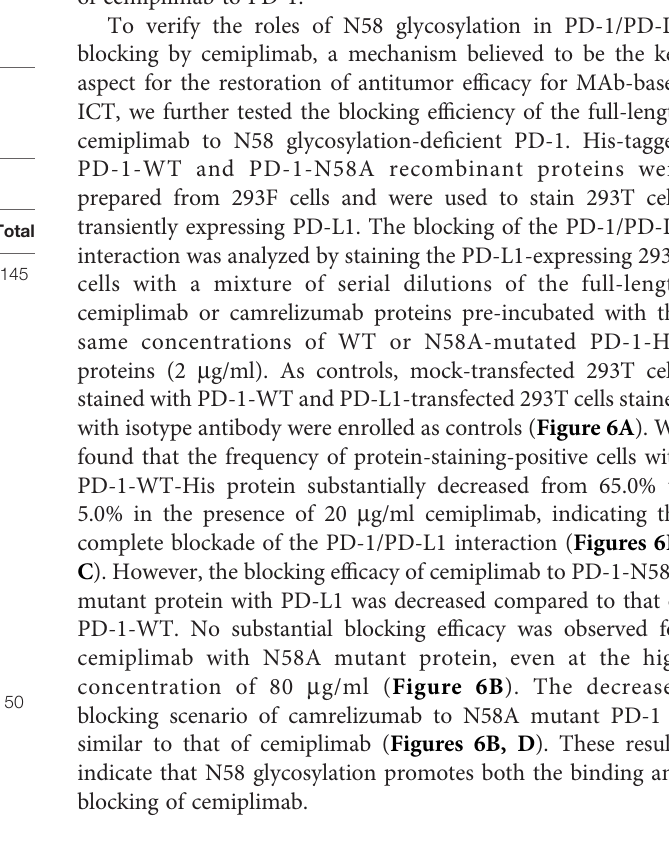
a Numbers represent the number of atom-to-atom contacts between cemiplimab and PD-1 residues, which were analyzed by the Contact program in CCP4 suite (the distance cutoff is